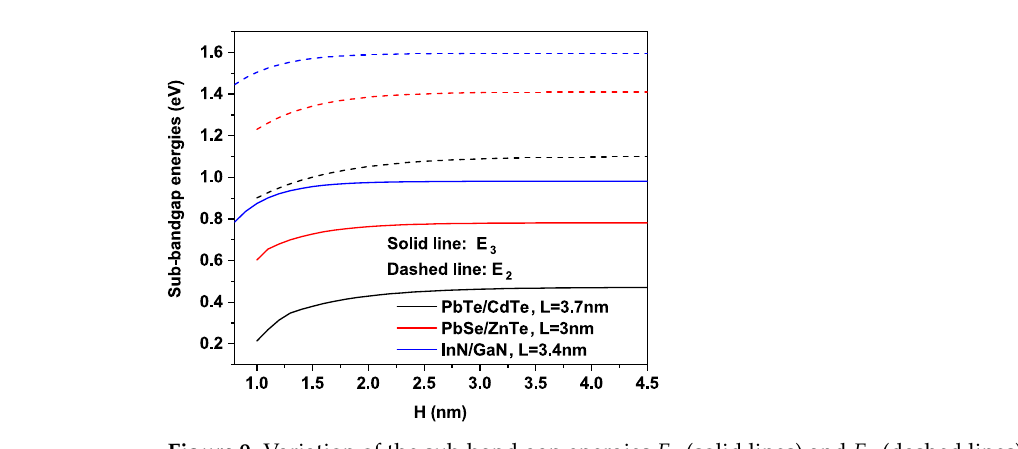
Figure 9. Variation of the sub-band gap energies E 2 (solid lines) and E 3 (dashed lines) versus inter- dot size H at the optimum dot size L = 3.7 nm, 3 nm and 3.4 nm for PbTe/CdTe, PbSe/ZnTe and InN/GaN QD materials.